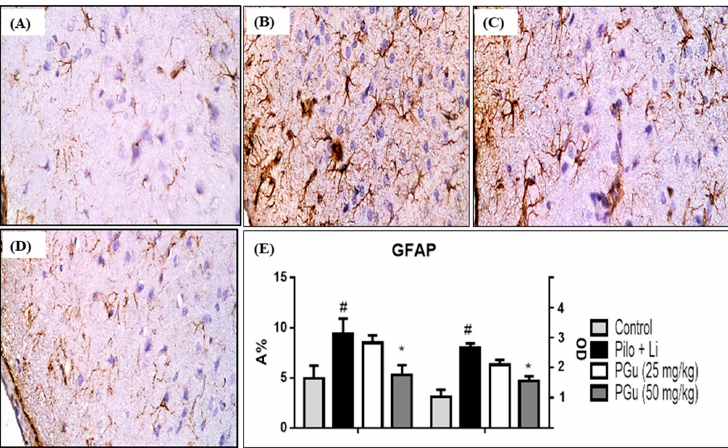
Figure 6. Photomicrographs of cerebral cortex neurons stained with immunohistochemical staining showing Glial fibrillary acidic protein (GFAP) expression in animals of the normal control group ( A ), pilocarpine status epilepticus group ( B ), PGu (25mg / kg b.w.) ( C ), and PGu (50 mg / kg b.w.) ( D ) pretreated groups with 40 × magnification power while ( E ) shows quantitative image analysis for GFAP immunohistochemical staining expressed as optical densities (OD) across 7 di ff erent fields for each rat section. LiCl was injected at a dose of (mEq / kg b.w., i.p.). After 24 h, the animals were injected with pilocarpine hydrochloride at a dose of 30 mg / kg b.w. PGu was given in doses of 25 and 50 mg / kg twice and the second dose was given 1 h before pilocarpine. Data are presented as mean ± S.E. The superscripts # and * indicate significance in relation to the control and pilocarpine + lithium-treated groups, respectively, at p <